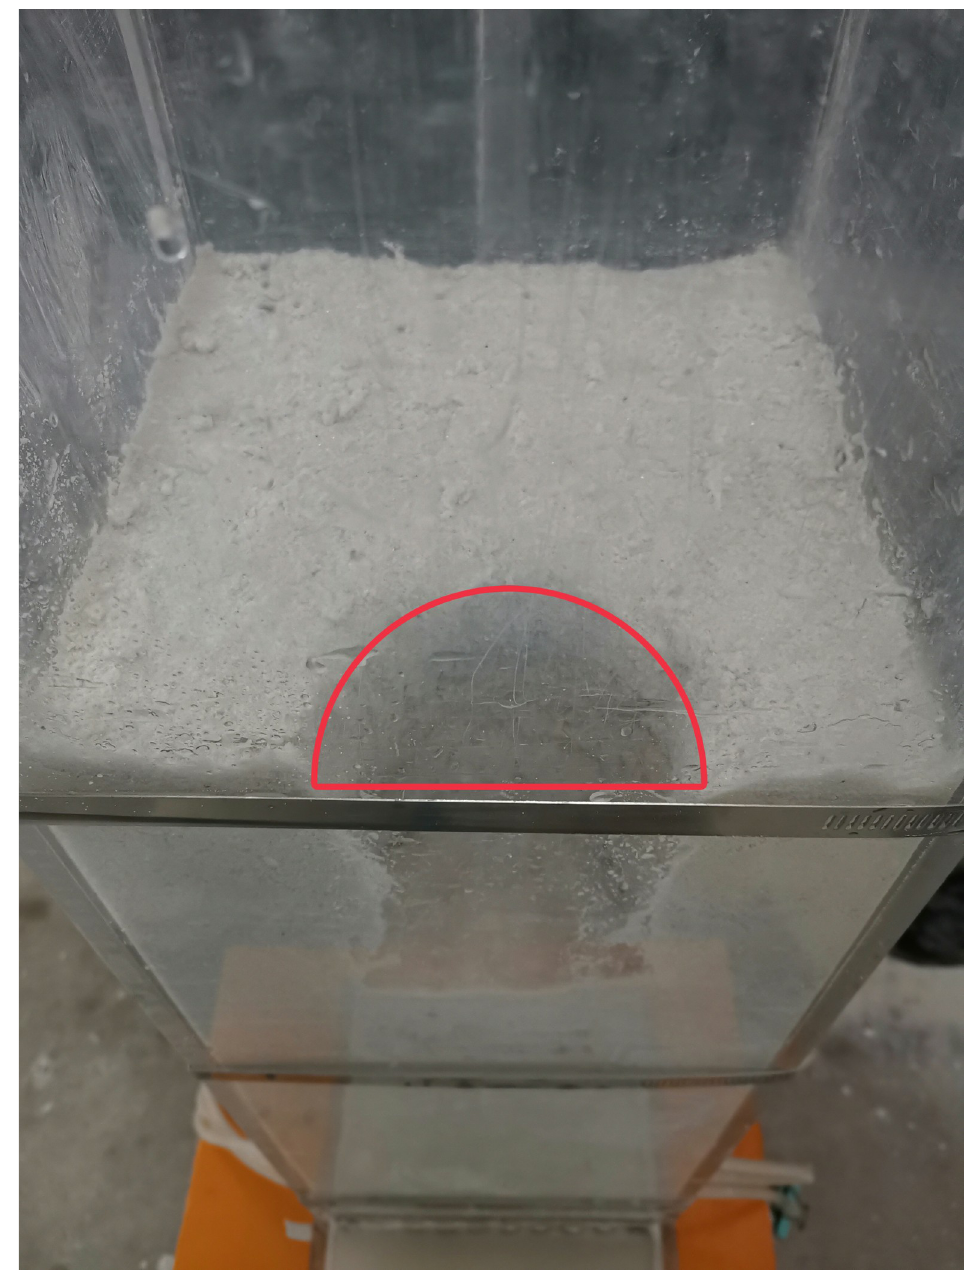
Fig 5. Semicircular collapse pit at top of Soil